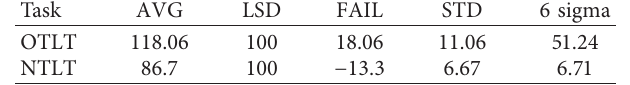
Table 8: Reliability comparison.